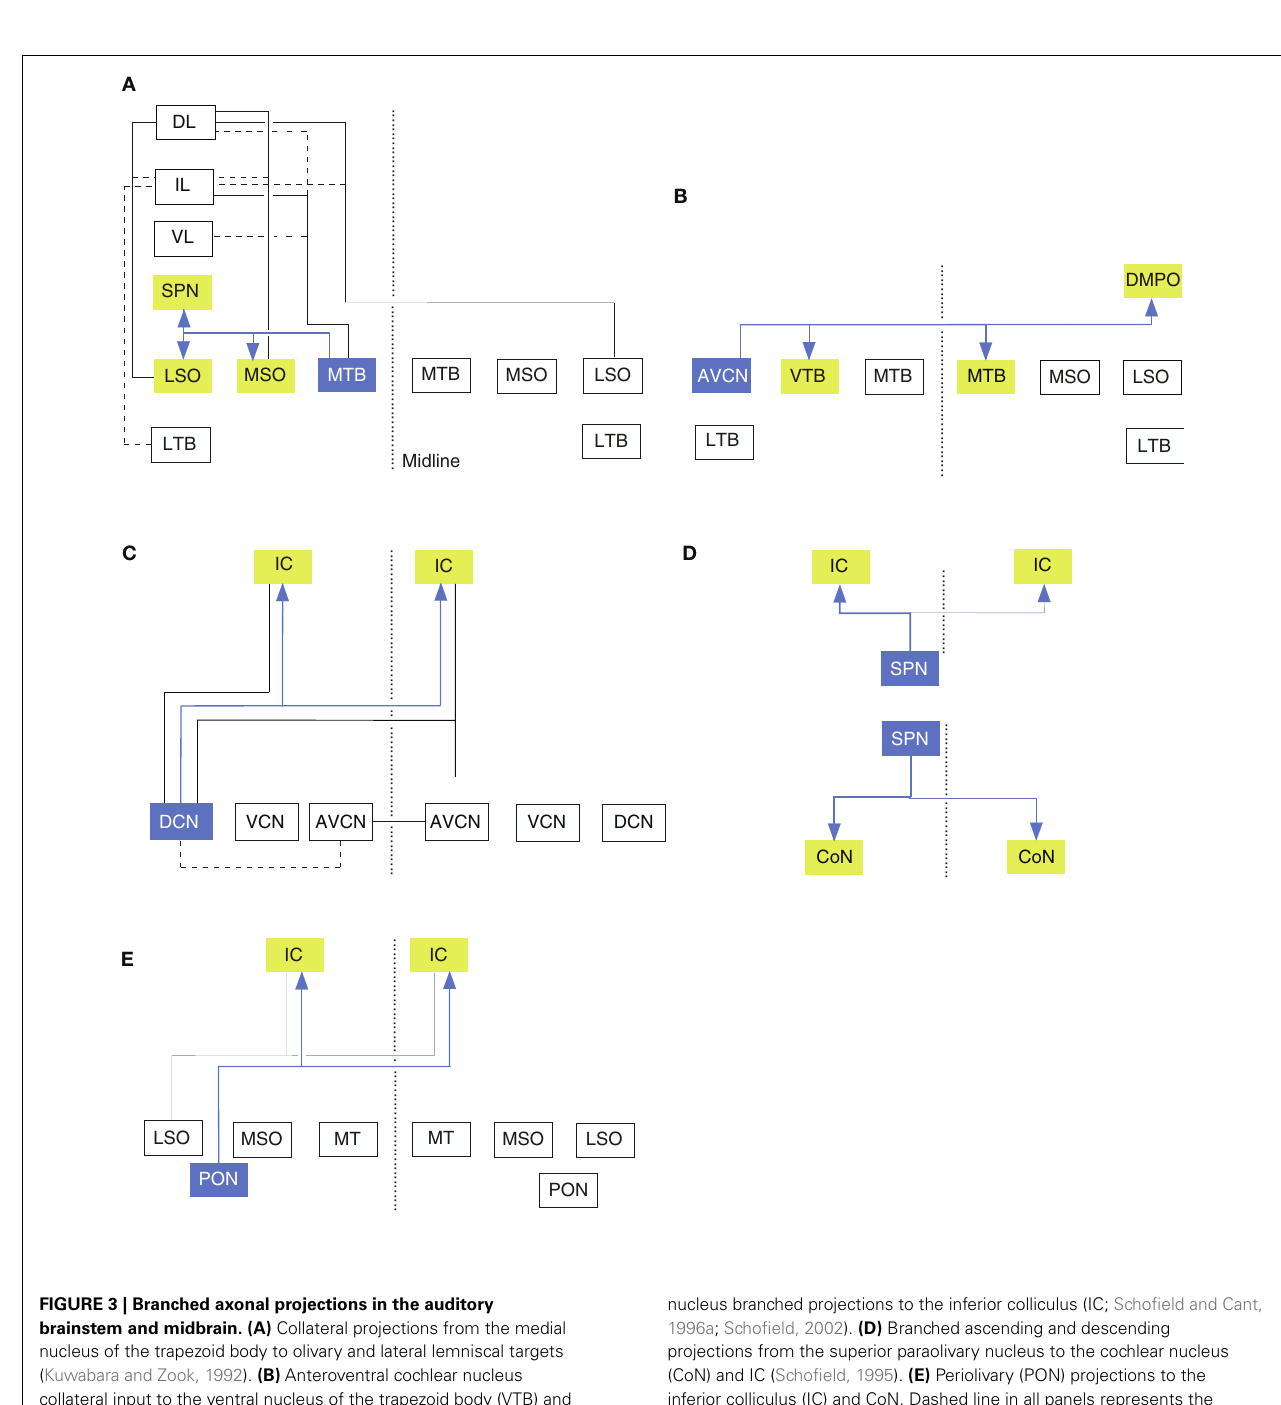
nucleus branched projections to the inferior colliculus (IC; Schofield and Cant, 1996a; Schofield, 2002). (D) Branched ascending and descending projections from the superior paraolivary nucleus to the cochlear nucleus (CoN) and IC (Schofield, 1995). (E) Periolivary (PON) projections to the inferior colliculus (IC) and CoN. Dashed line in all panels represents the